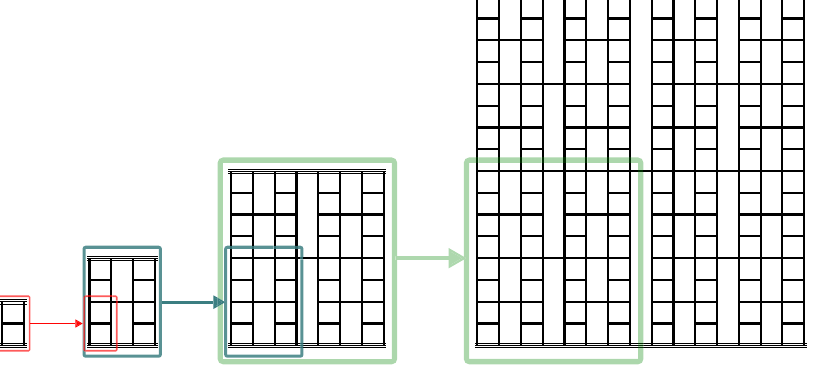
Figure 1. Hierarchical fuse network. Deterministic recursive construction of a hierarchical fuse network (D-HFN); a network of n hierarchical levels consists of 4 modules, each of which represents a network of n − 1 hierarchical levels; a network of n + 1 hierarchical levels is generated from a n -level network by substituting each of these 4 modules by the level- n